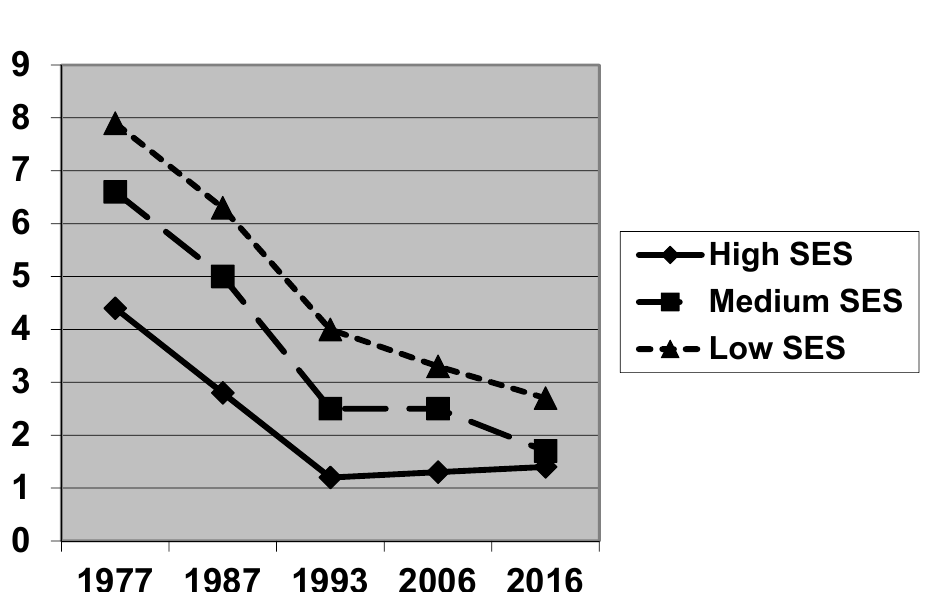
Figure 1. Caries experience (dmft including initial caries) in preschool children in Hamburg 1977–2016, related to the families’ socio-economic status (SES).